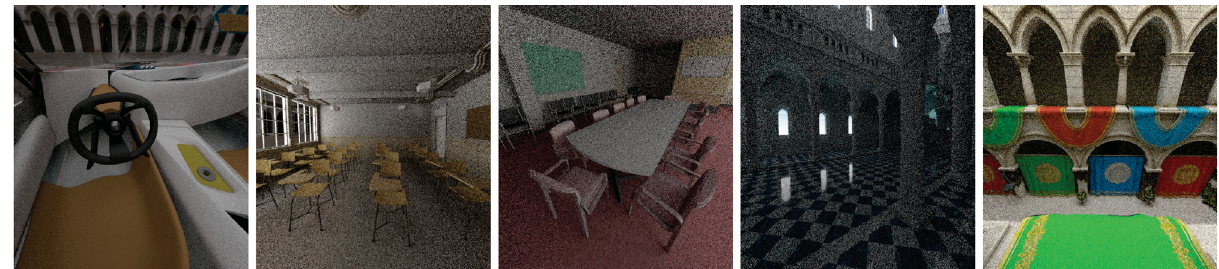
Fig. 2 Sample views of test scenes used in the user study. Left to right: BMW, Classroom, Conference, Sibenik, and Sponza.